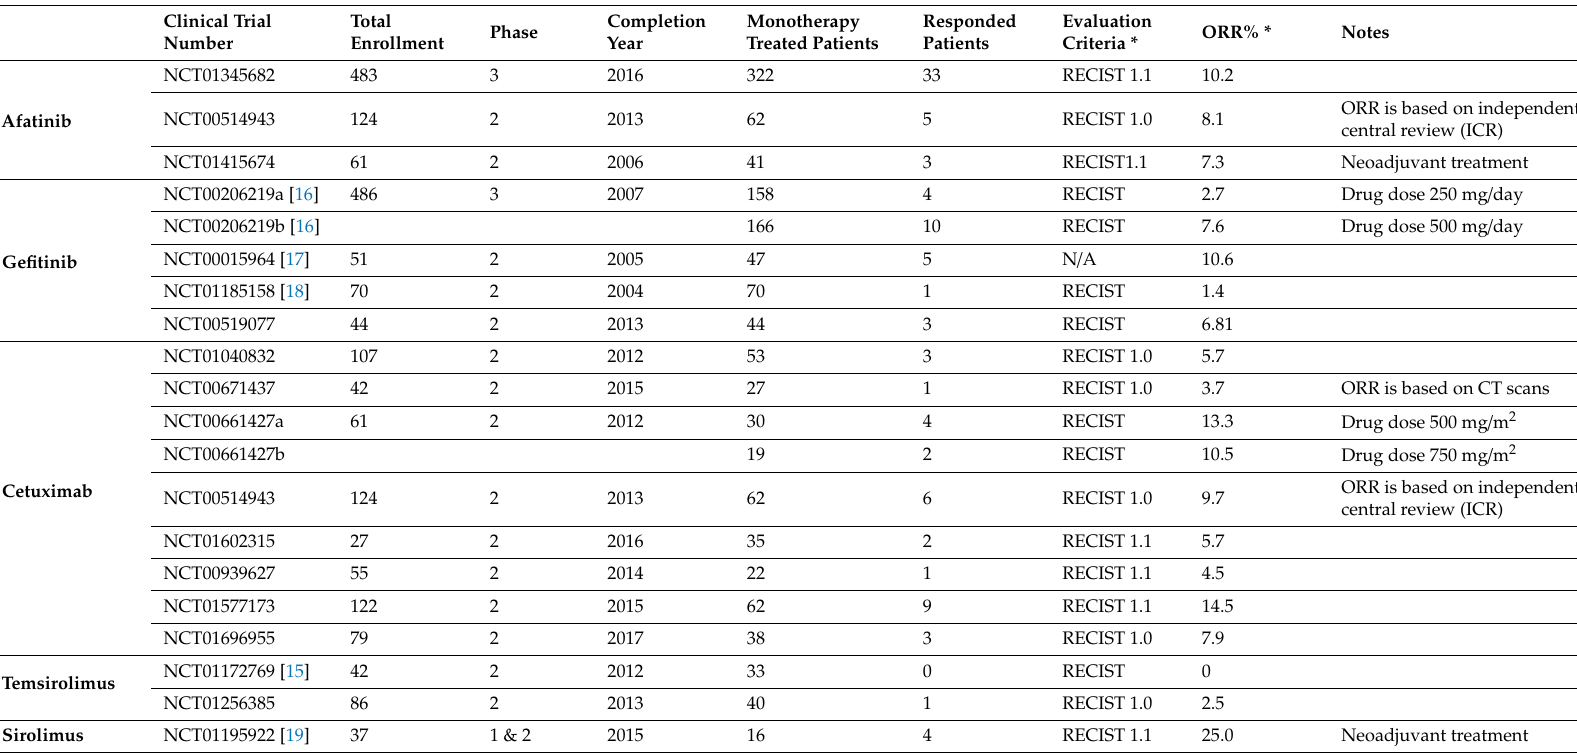
Table 2. Objective response rates in clinical trials of anticancer compounds used as monotherapies in head and neck cancer patients. Data collected from https: //